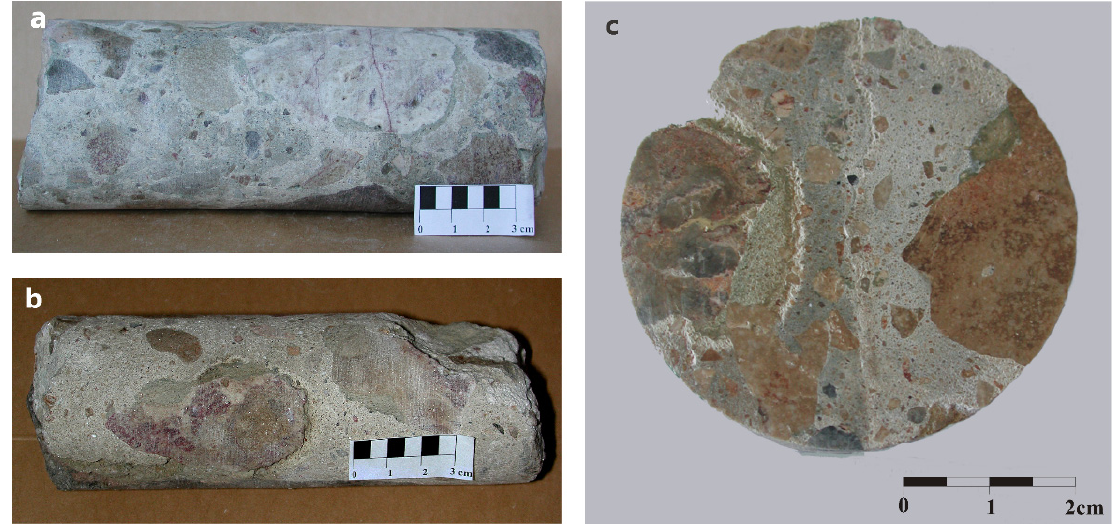
Figure 4. Fragments of cores from the Camarasa Dam. ( a ) Type A concrete; ( b ) type B concrete; ( c ) core section: the left half is made up of type B concrete and the right half is type A.